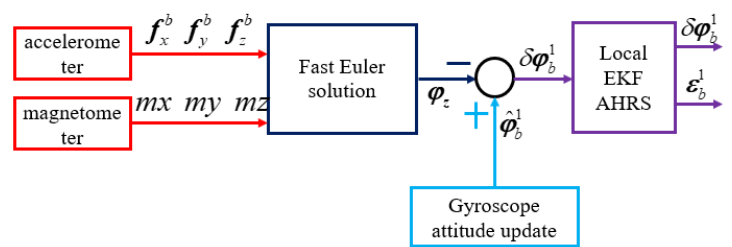
Figure 5. The nonlinear attitude heading reference system (AHRS) local extended Kalman filter (EKF)